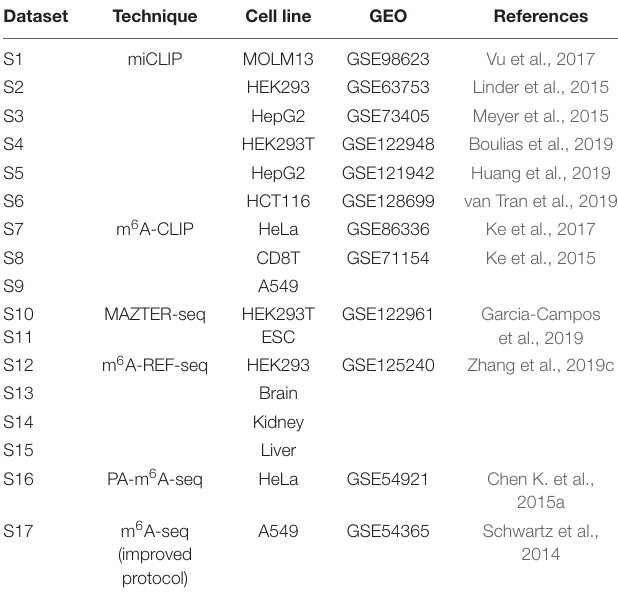
TABLE 1 | Base-resolution or high resolution datasets of m 6 A sites. Dataset